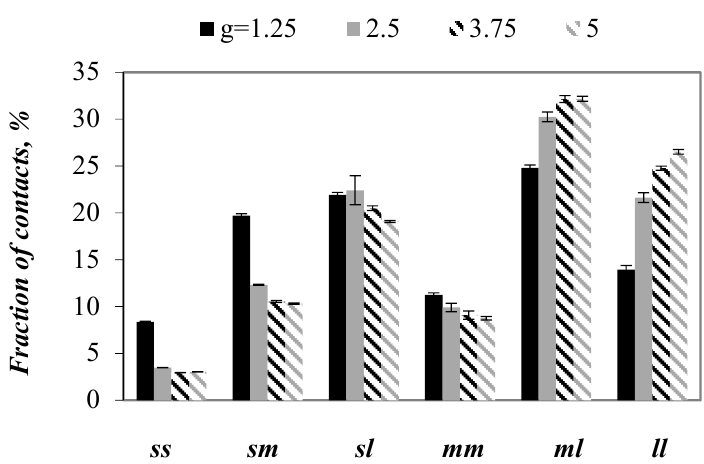
Figure 7. Percentage of number of contacts between small spheres ( ss ), small and medium spheres ( sm ), small and large spheres ( sl ), medium spheres ( mm ), medium and large spheres ( ml ), and large spheres ( ll ) in packings with various values of g when subjected to a vertical load of 100 kPa.